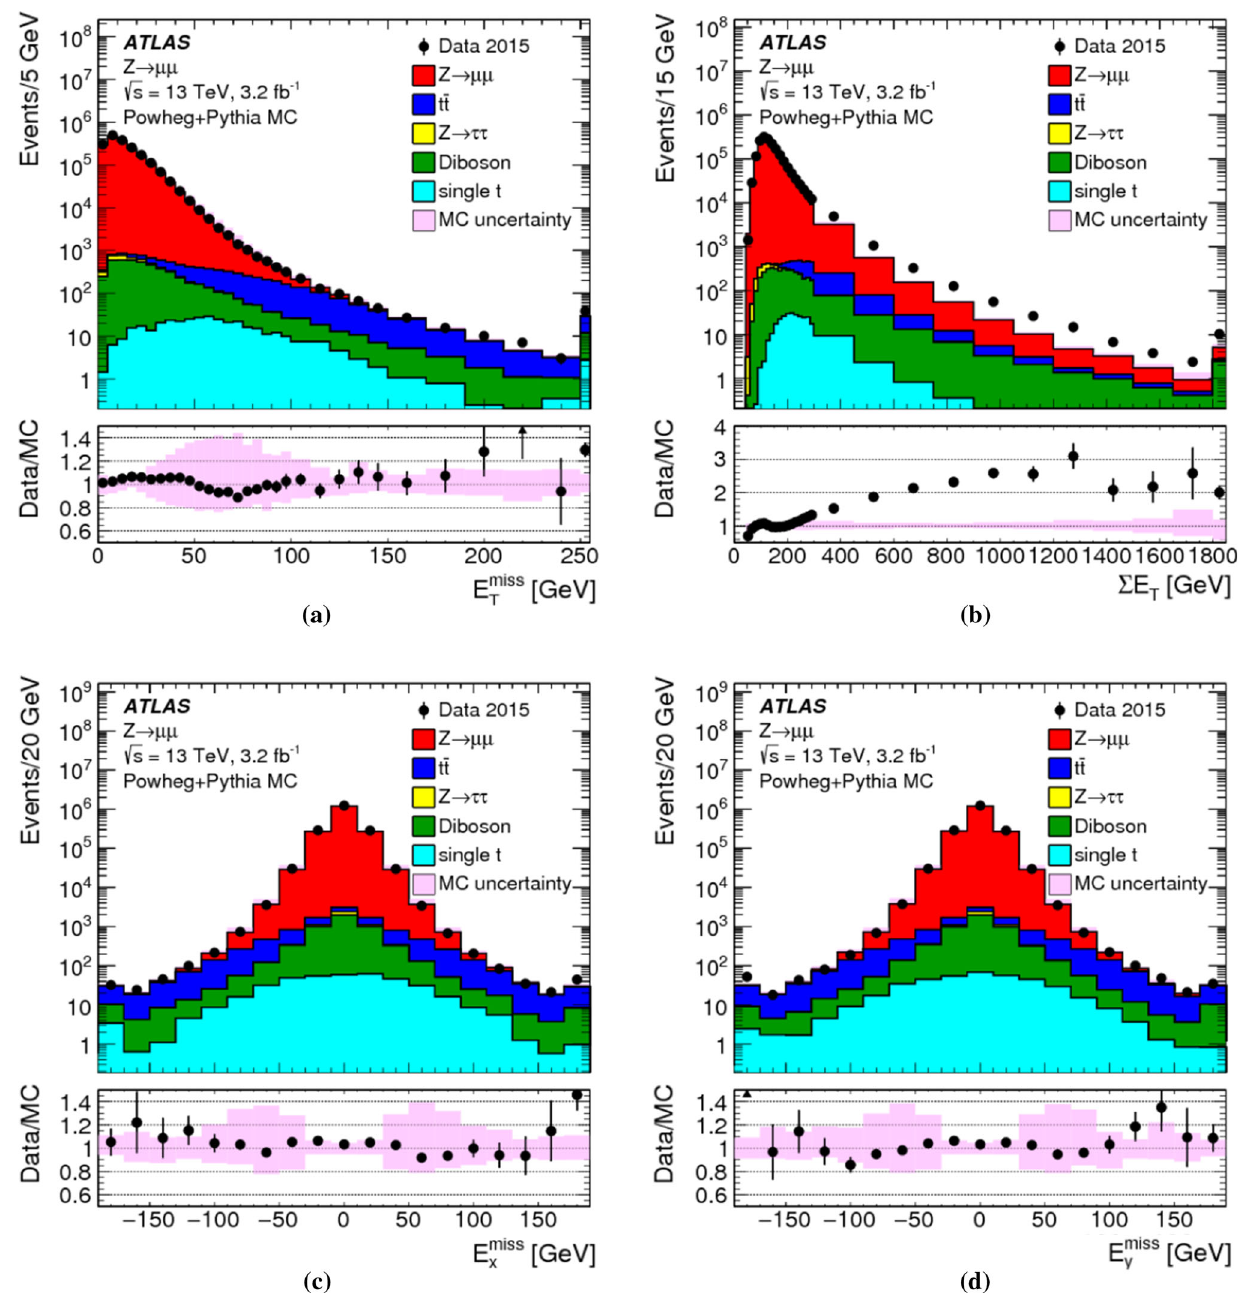
p T scale and resolution which are contributed by muons, jets, and the Fig. 1 Distributions of a E miss , b (cid:10) E T , c E miss x and d E miss y for an T inclusive sample of Z → μμ events extracted from data and compared soft term. The last bin of each distribution includes the overflow, and the toMCsimulationsincludingallrelevantbackgrounds.Theshadedareas firstbincontainstheunderflow in c and d .Therespectiveratiosbetween indicate the total uncertainty for MC simulations, including the overall data and MC simulations are shown below the distributions, with the statistical uncertainty combined with systematic uncertainties from the shaded areas showing the total uncertainties for MC